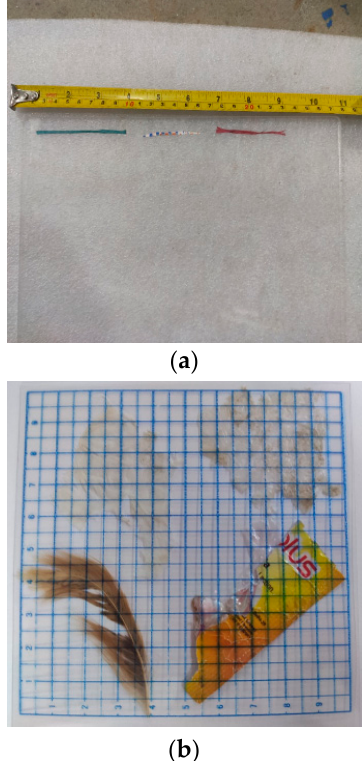
Figure 15. The calibration method of foreign fiber size. ( a ) The length of the linear foreign fiber and ( b ) the area of the irregular foreign fiber.